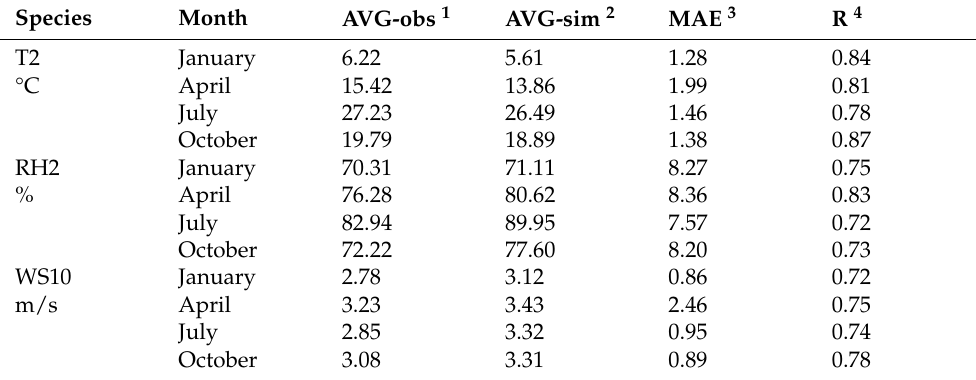
Table 1. Performance statistics for temperature at 2 m (T2), relative humidity at 2 m (RH2), wind speed at 10 m (WS10) at 150 sites within the study